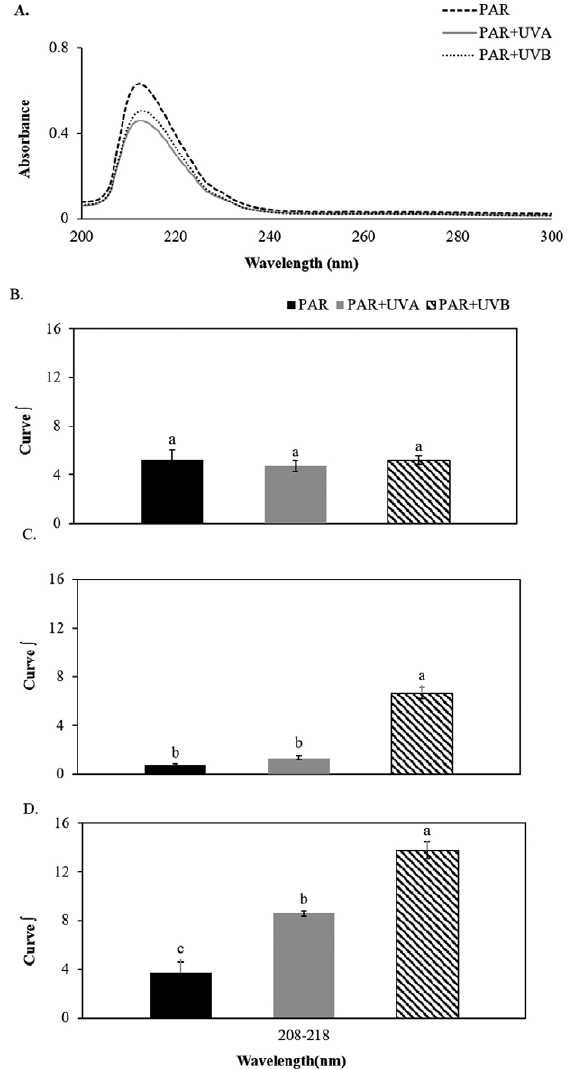
Fig. 5. – Absorption spectrum of methanolic extract and area un- Fig. 6. – Absorption spectrum of seawater and area under the curve der the curve (AUC) of maximal UV-visible absorption bands. A, (AUC) of maximal UV-visible absorption bands. A, general UV general UV spectrum at T4; B, C and D, the AUC (n=5; mean±SD) spectrum at T4; B, C and D, the AUC (n=5; mean±SD) at T4, T7, at T4, T7, and T10 of radiation exposure, respectively, at three and T10 of radiation exposure, respectively, at 208-218 nm. Let- specific UV-absorption bands, 208-218, 260-276 and 328-350 nm, ters indicate differences according to unifactorial ANOVA and the and two specific visible-absorption bands, 430-450 and 600-670 Newman-Keuls post hoc test nm. Letters indicate differences according to unifactorial ANOVA and the Newman-Keuls post hoc test (p<0.05). The analyses were performed for each absorption band separately.